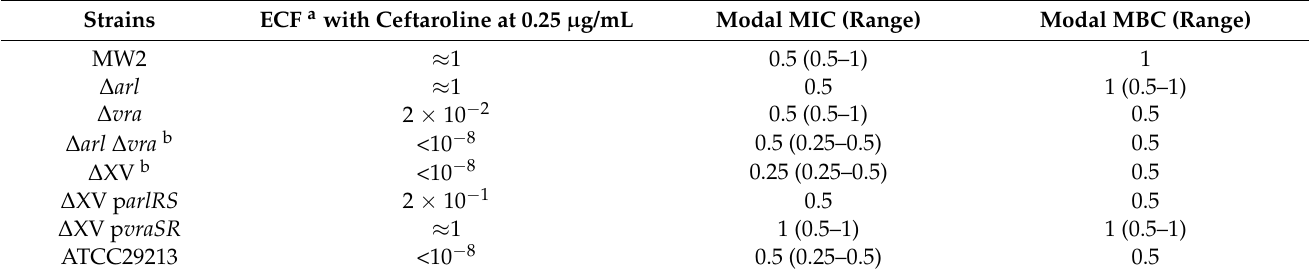
Table 1. ECF a on 0.25 µ g/mL of ceftaroline-supplemented agar and MIC/MBC.